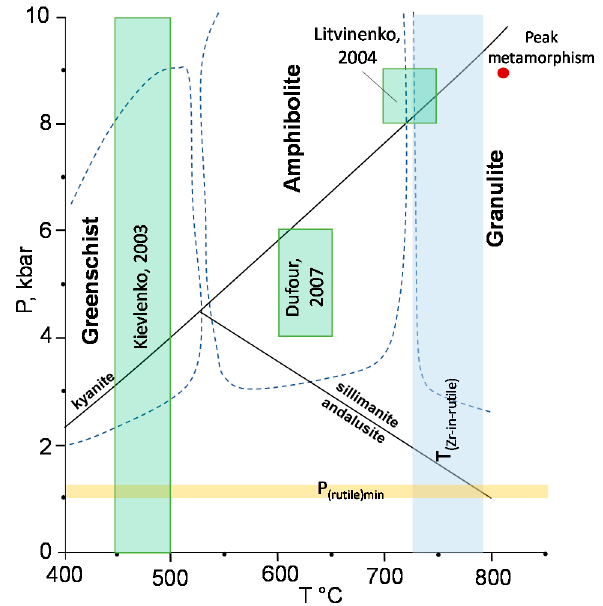
Figure 15. Temperature vs. pressure binary plot showing formation conditions of Snezhnoe ruby recorded in rutiles: Zr-in-rutile thermometer T (Zr-in-rutile) (blue vertical field) and Raman mapping of rutile inclusions P (rutile)min (horizontal yellow line). The existing literature data by Kievlenko [40], Dufour [9] and Litvinenko [44,45] are shown as green fields. The peak metamorphism conditions are shown as red point after [18,19]. The stability fields of aluminosilicates (divided by black lines) are after [52]. Schematic fields of Greenschist, Amphibolite and Granulite metamorphic facies are shown for